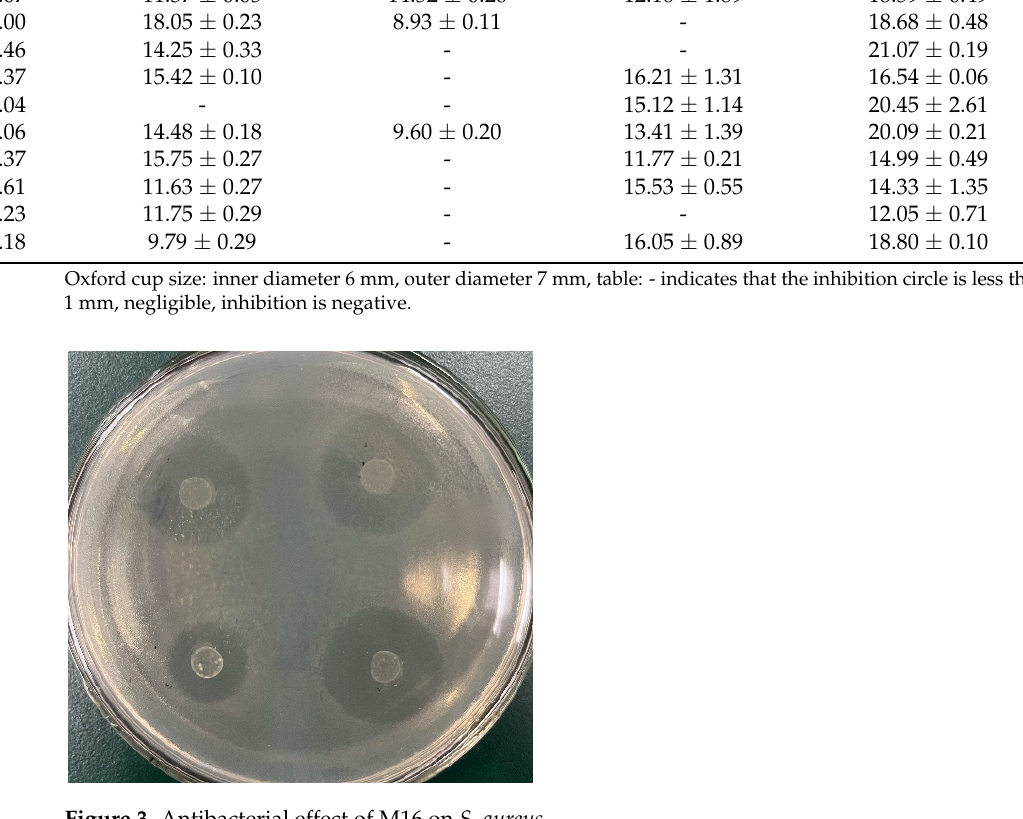
Figure 3. Antibacterial effect of M16 on S. aureus. Table 4. Inhibition results of the screened LAB (top 16 strains).